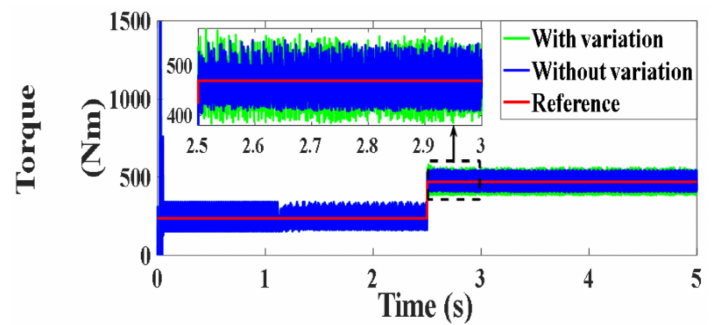
Figure 99. Developed torque under PVC (Nm).